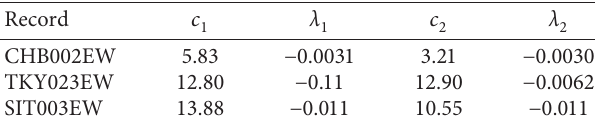
Figure 6: Instantaneous amplitudes for truncated velocity time series. (a) CHB002EW and (b) TKY023EW. Table 2: Envelope parameters for truncated long-period velocity surface